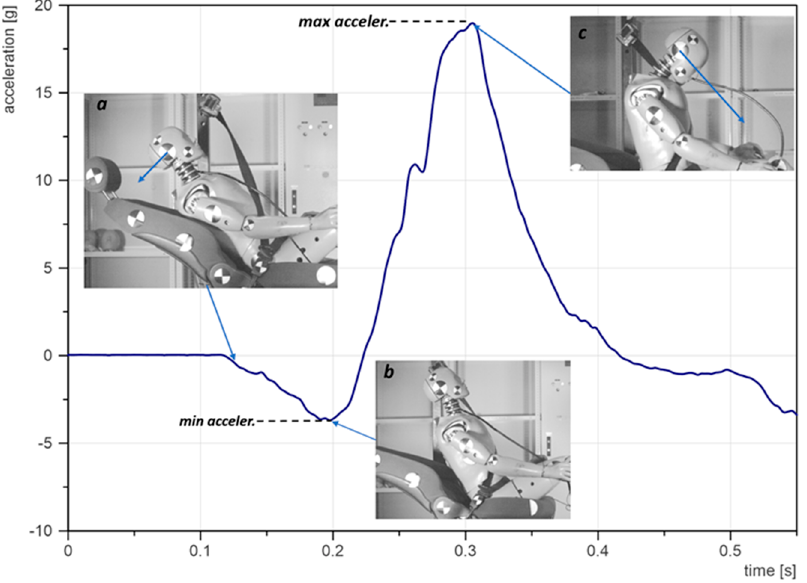
Figure 4. Head acceleration of the dummy: ( a ) seatback angle 110°; ( b ) seatback angle 130°; ( c ) seatback angle 145°.